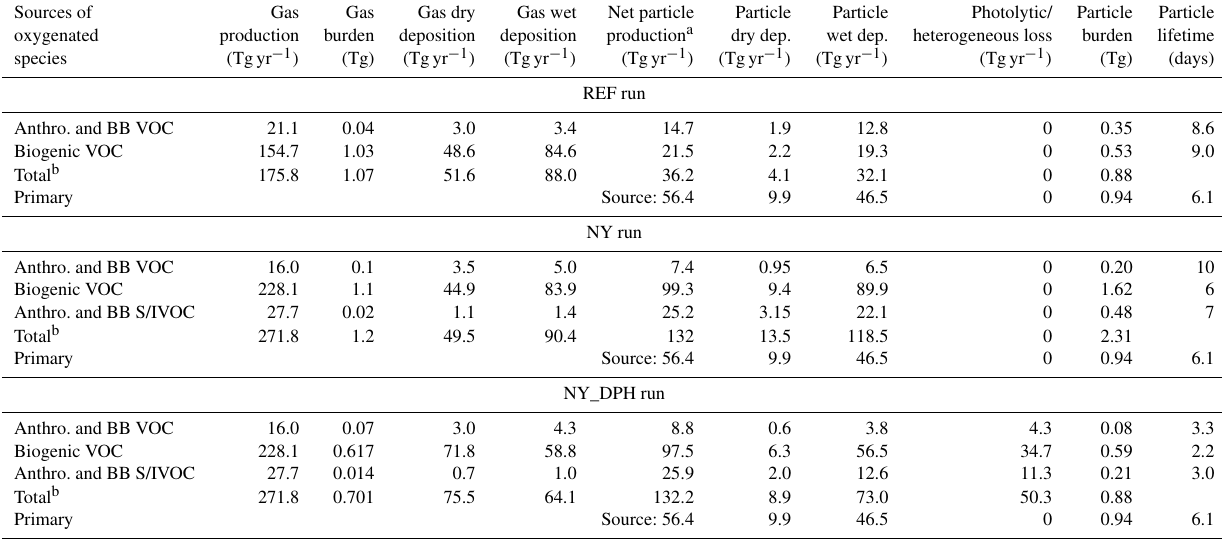
Table 5. Global annual-average budgets for organic gases and particles for the 4-year (2005–2008) period. VOC from anthropogenic, biomass burning (BB) and biogenic sources are indicated, as well as S/IVOC from anthropogenic and BB sources. Sources of